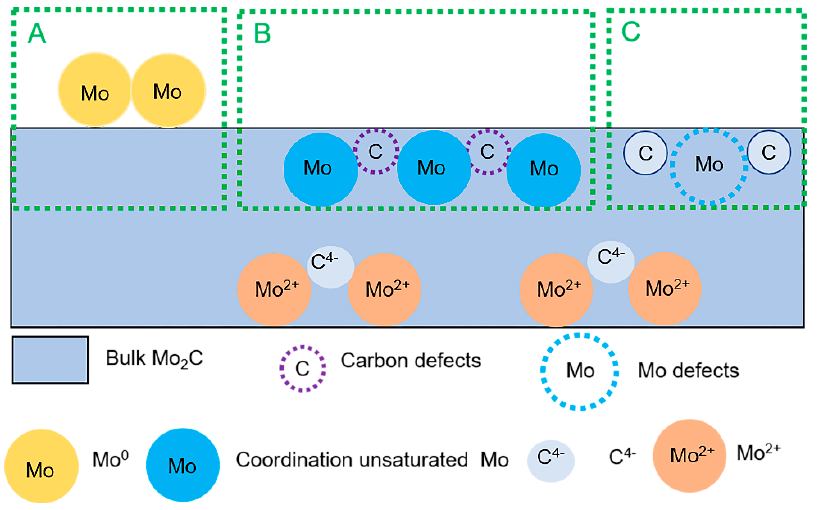
Table 4. The percentage content of Mo species calculated from the XPS spectra.